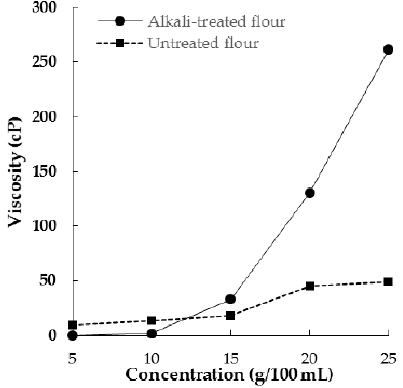
Figure 2. Apparent viscosity of untreated and alkali-treated defatted rambutan seed